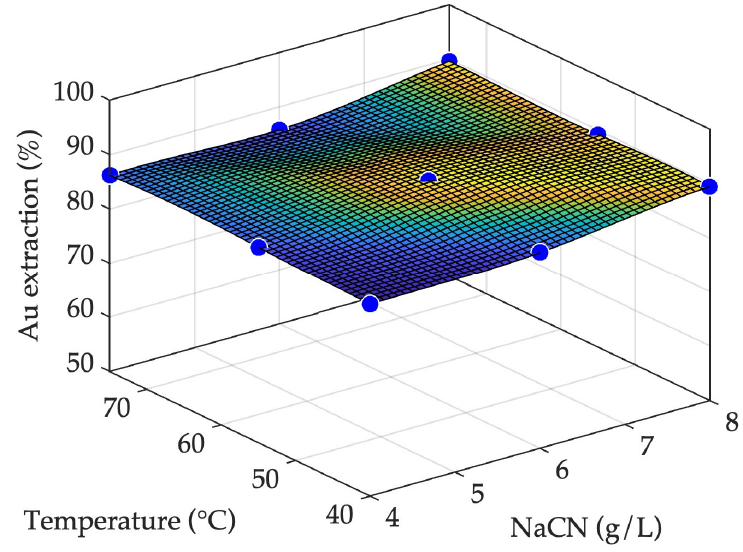
Figure 6. Effects of cyanide concentration on Au extraction (%) during simultaneous pressure leaching and oxidation at a pressure of 0.8 MPa.